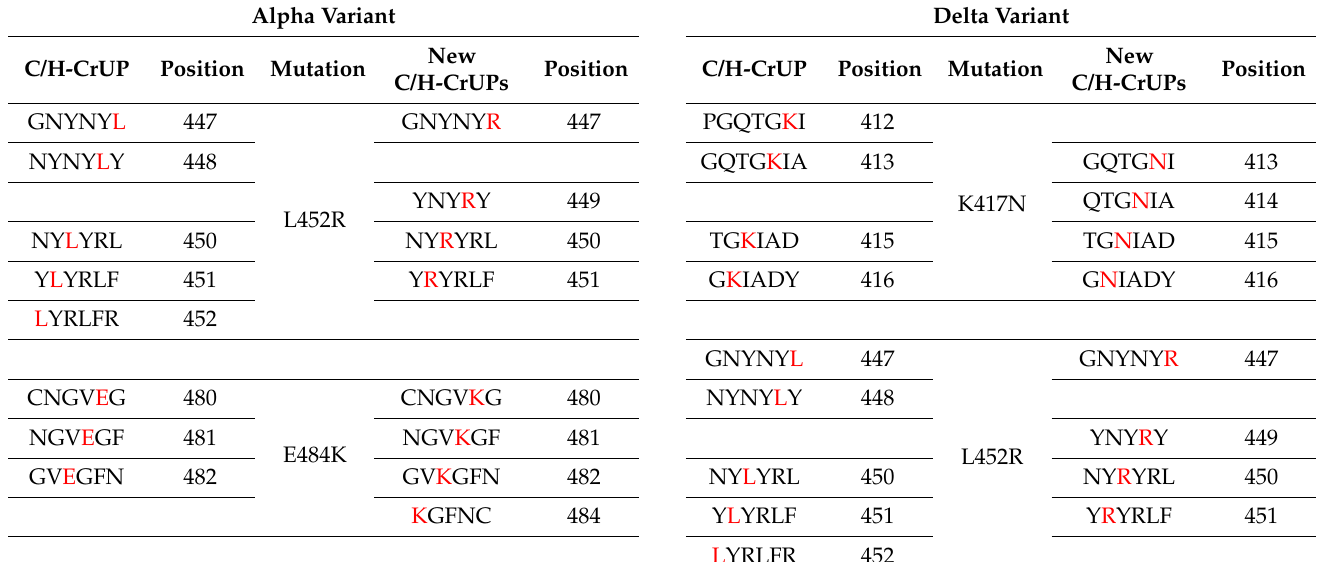
Figure 1. Mutations in different virus variants. ( A ) The mutations of the Receptor-Binding Motif (RBM) included in the Receptor-Binding Domain (RBD) are presented. ( B ) The mutations around the Spike cleavage sites are presented. Purple blocks mark the point mutation sites in the variants. Green colors indicate the Universal Peptides of the Spike proteins from Figure S2. Yellow colors mark the Receptor-Binding Domain of Spike protein interaction with ACE2. Pink colors mark the Receptor-Binding Motif. Cyan colors indicate the NF9 peptide, while light blue colors mark the Bridge between S1 and S2 domains. Red-colored arrows indicate the cleavage sites. With different colors in the upper side of the alignment, the different domains of the Spike protein are presented. Table 2. C/H-CrUPs constructed aroud the mutations in RBD of Alpha, Delta and Omicron SARS- CoV-2 variants.